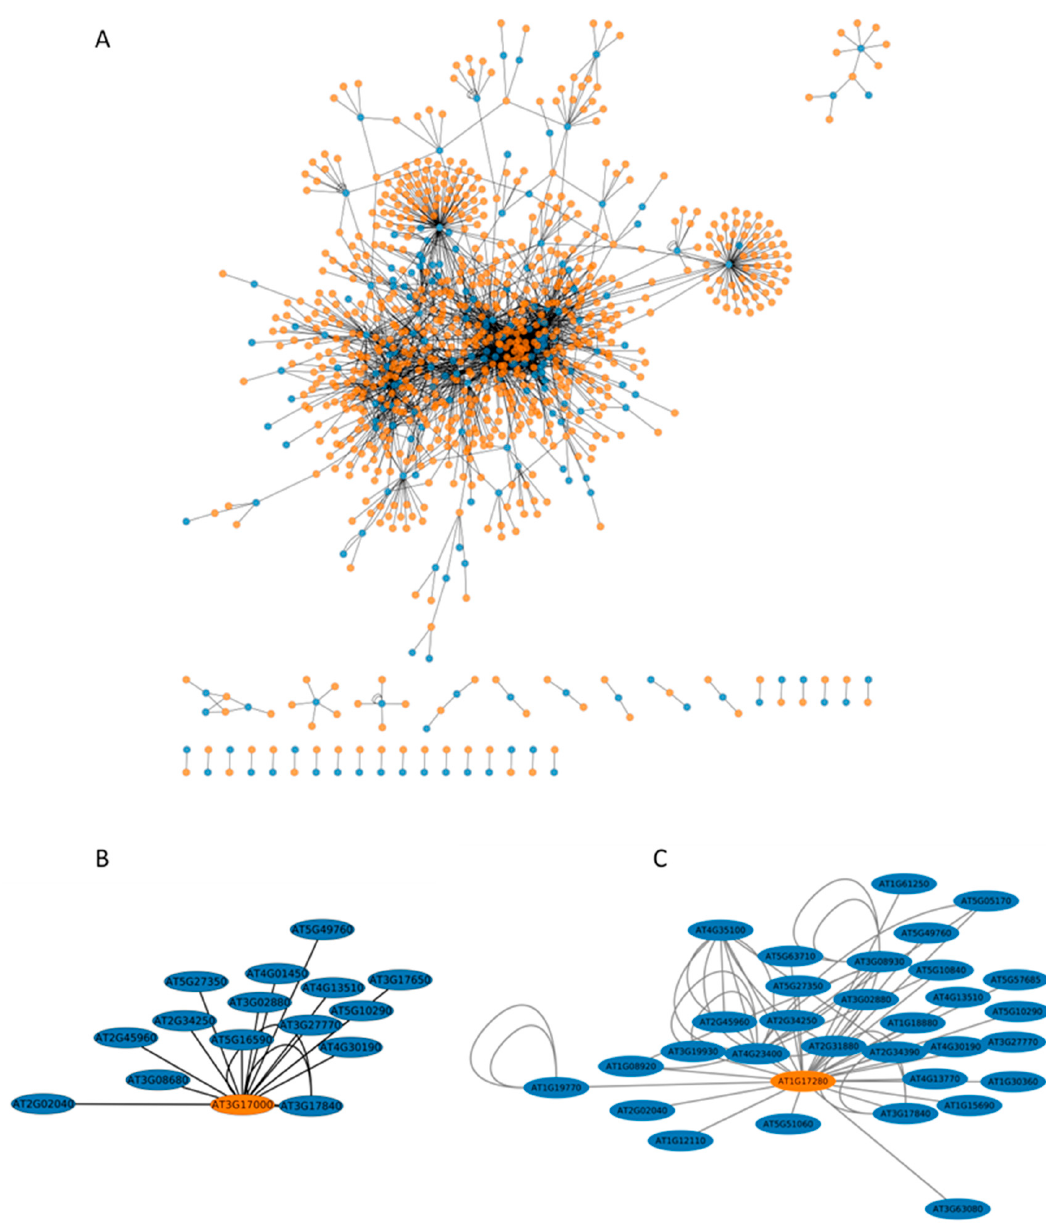
Figure 5. The interaction network of ubiquitinated proteins. Interactants from a Y2H approach [15] and Split-Ub approach [16,20] were considered, and the network was visualized by Cytoscape (version 3.7.2). ( A ) The network includes ubiquitinated proteins (blue) together with their reported interactants (orange) (details in Table S7a). ( B ) The UBC32 subnetwork (details in Table S7b). ( C ) The UBC34 subnetwork (details in Table S7c).